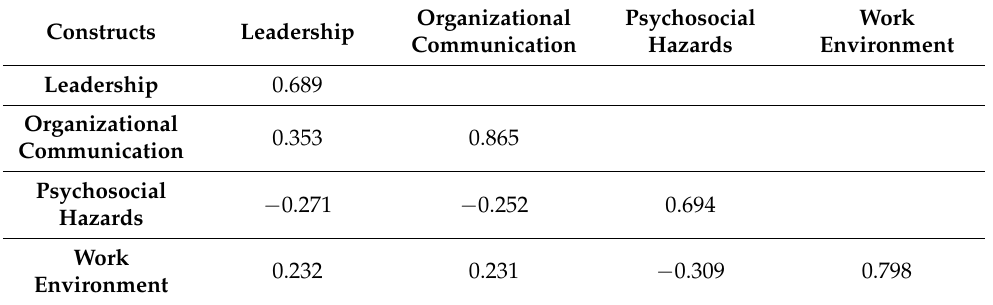
Table 4. Discriminant